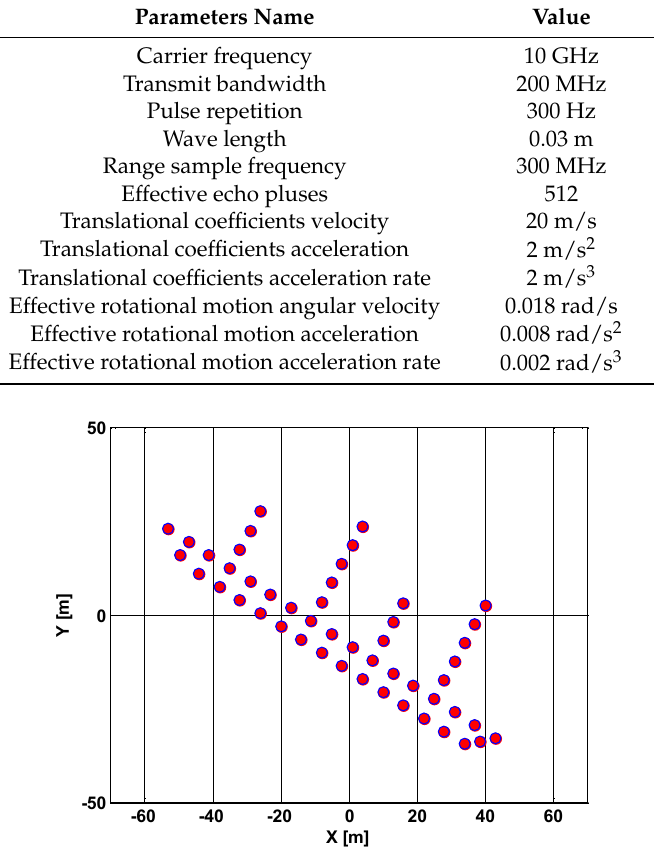
Figure 7. Vessel model of the ISAR imaging.